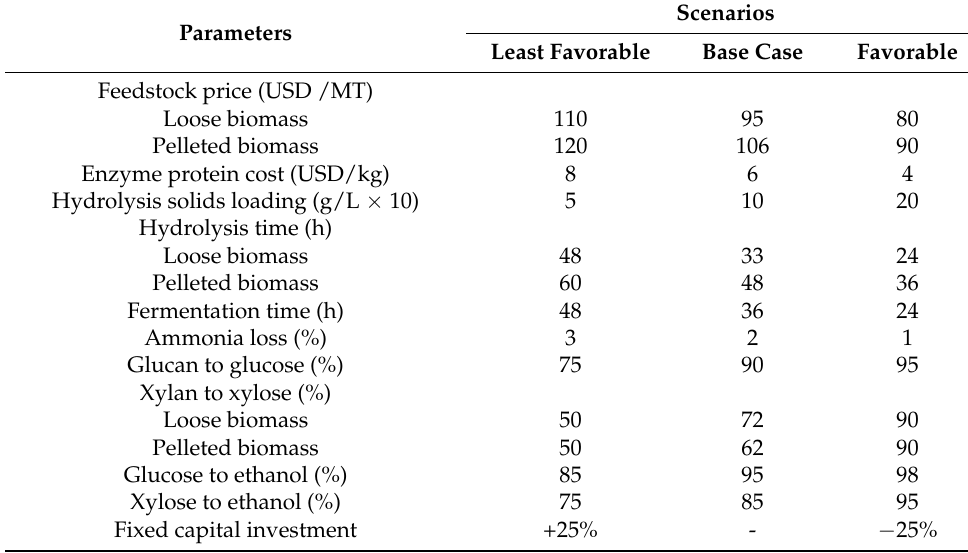
Table 7. Sensitivity analysis assumptions for loose (PT2 at high enzyme loadings) and pelleted biomass (PT3 at low enzyme